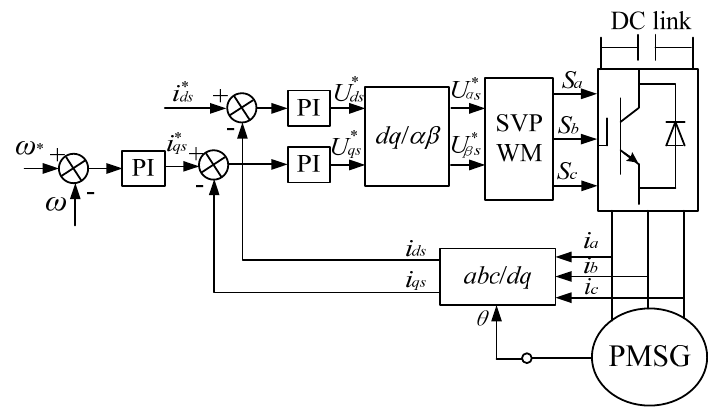
Figure 6. Control diagram of the power wind turbines.